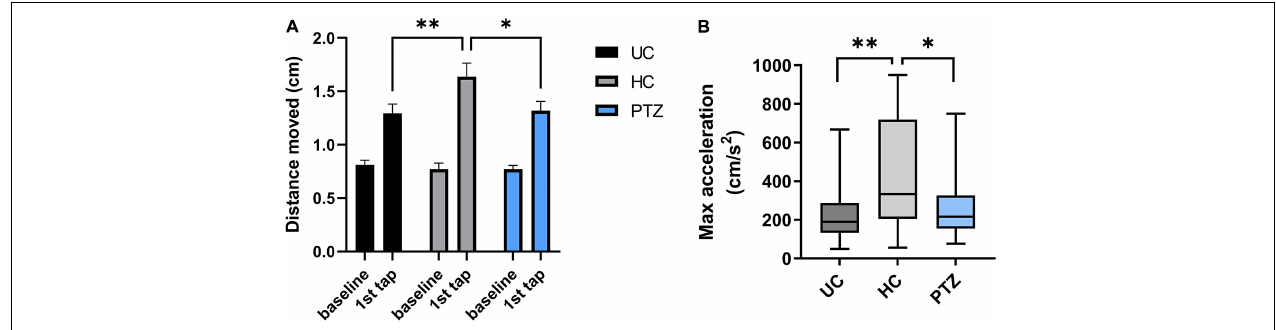
FIGURE 4 | Enhanced acoustic startle response in handling control (HC) fish. The HC group had a more robust reaction to a startling stimulus, indicating that they may have an escape advantage over the other groups. (A) Two-way repeated measures ANOVA of distance moved in the first second from the start of the tap stimulus showed a significant effect of tap [ F ( 1 , 68 ) = 139.5, p < 0.0001] and of tap x experimental group [ F ( 2 , 68 ) = 4.826, p = 0.011]. Post-hoc Sidak’s multiple comparison test revealed a significant increase between baseline and first tap ( p < 0.0001) for all three experimental groups, demonstrating that all groups displayed an acoustic startle response (ASR). However, the post-hoc test also showed the HC group moved significantly further in response to the tap (in the first second from the start of the tap) compared to both untouched controls (UC) ( p = 0.007) and pentylenetetrazole (PTZ) ( p = 0.0141) groups. (B) . A Kruskal-Wallis test with a post-hoc Dunn’s multiple comparisons test revealed that HC fish also reached a higher max acceleration in the first second from the start of the tap, compared to both UC ( p = 0.001) and PTZ groups ( p = 0.029; graph shows median because the data were not normally distributed). * indicates p < 0.05; ** indicates p < 0.01; ns or unmarked indicates no significance p >